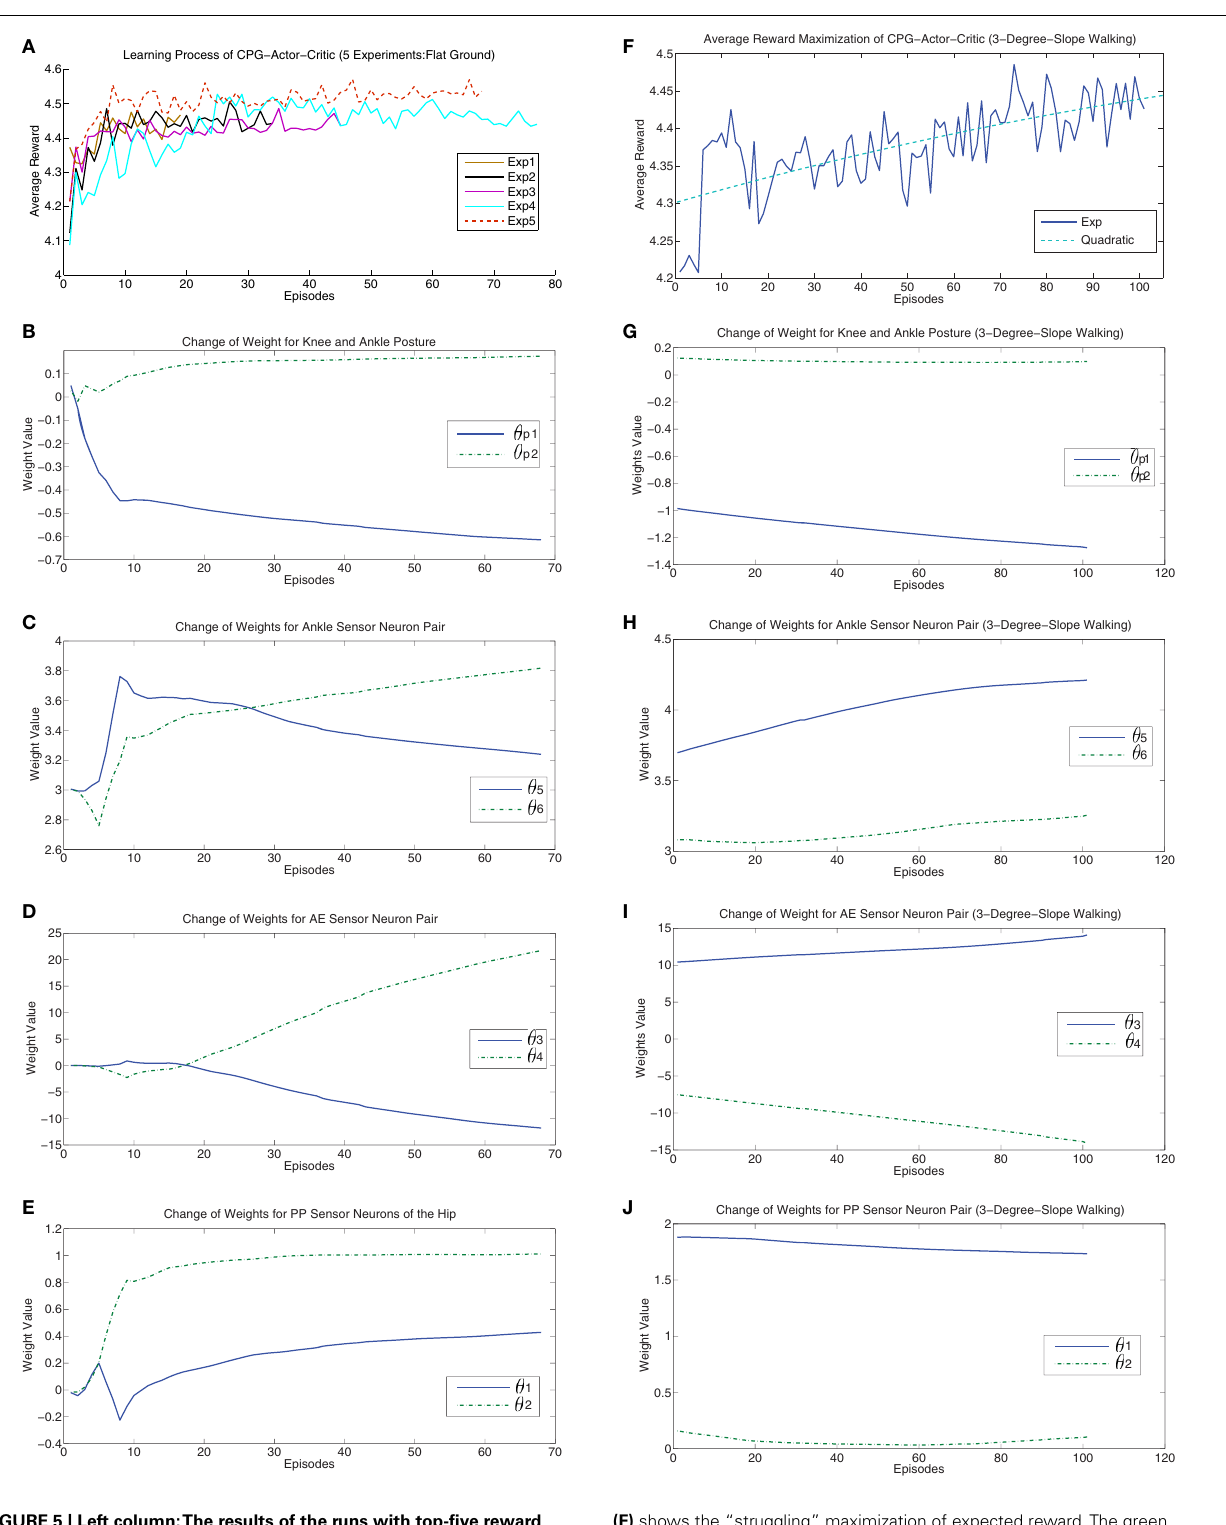
(F) shows the “struggling” maximization of expected reward.The green dash line shows a quadratic fitting of the increasing learning curve. (G–J) show how connection weights of CPGs are adaptively updated on the critical slope. For details of explanation, please refer to main text. All the “Episodes” mean updating episodes which exclude the episodes unable to satisfy updating